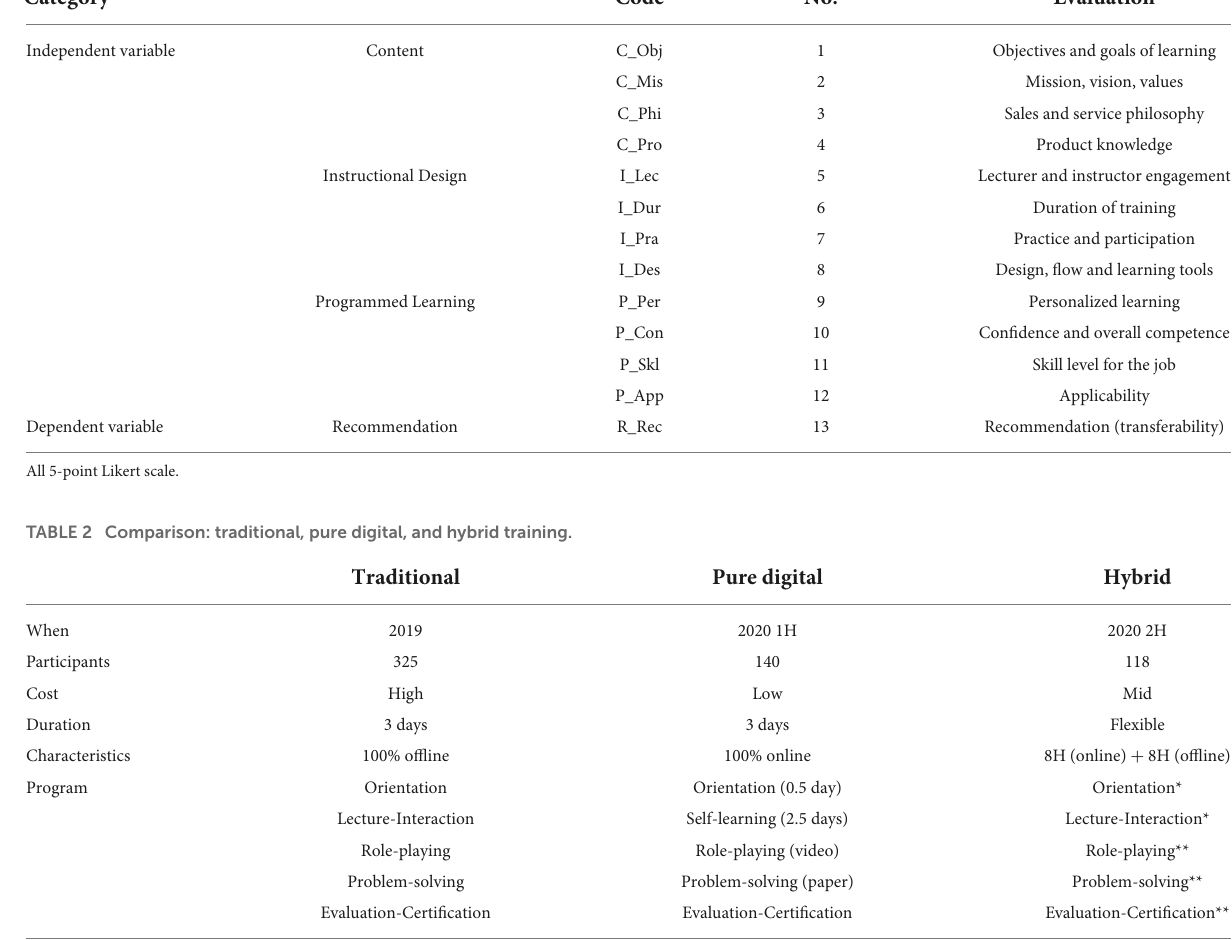
FIGURE3 CIP-R effectiveness model.